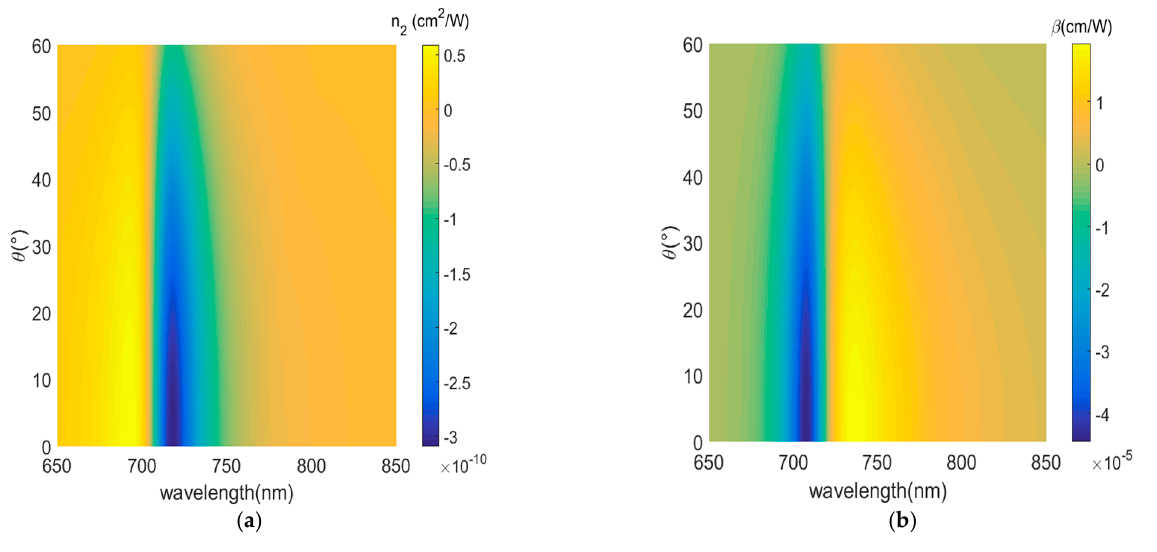
Figure 11. Nonlinear coefficient as a function of incident angle and gain medium concentration (0 mM). ( a ) Nonlinear refraction index 𝑛 (cid:2870) . ( b ) Nonlinear absorption coefficient β .